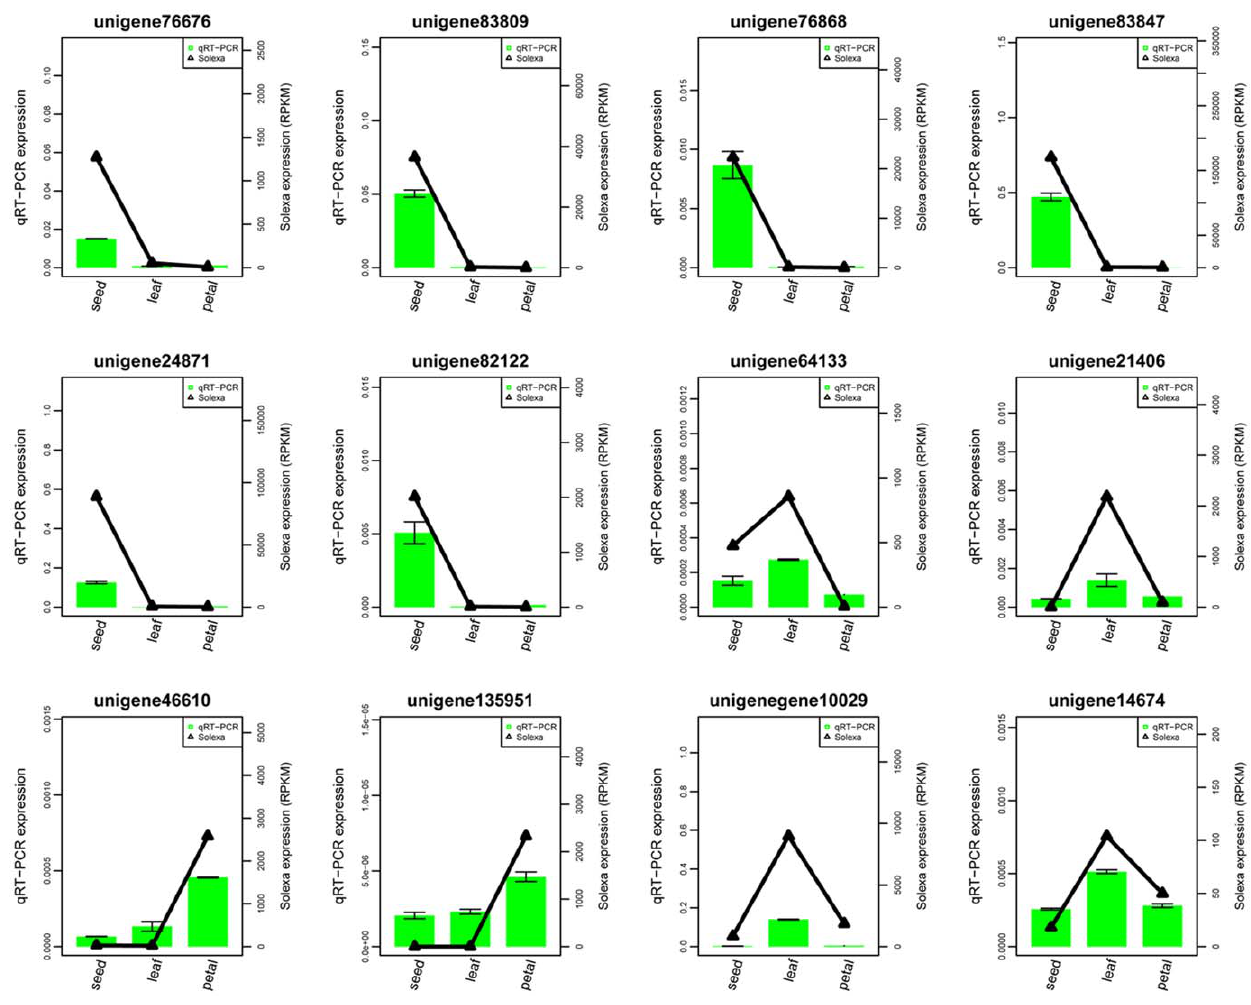
Figure 6. qRT-PCR validation of the selected unigenes.